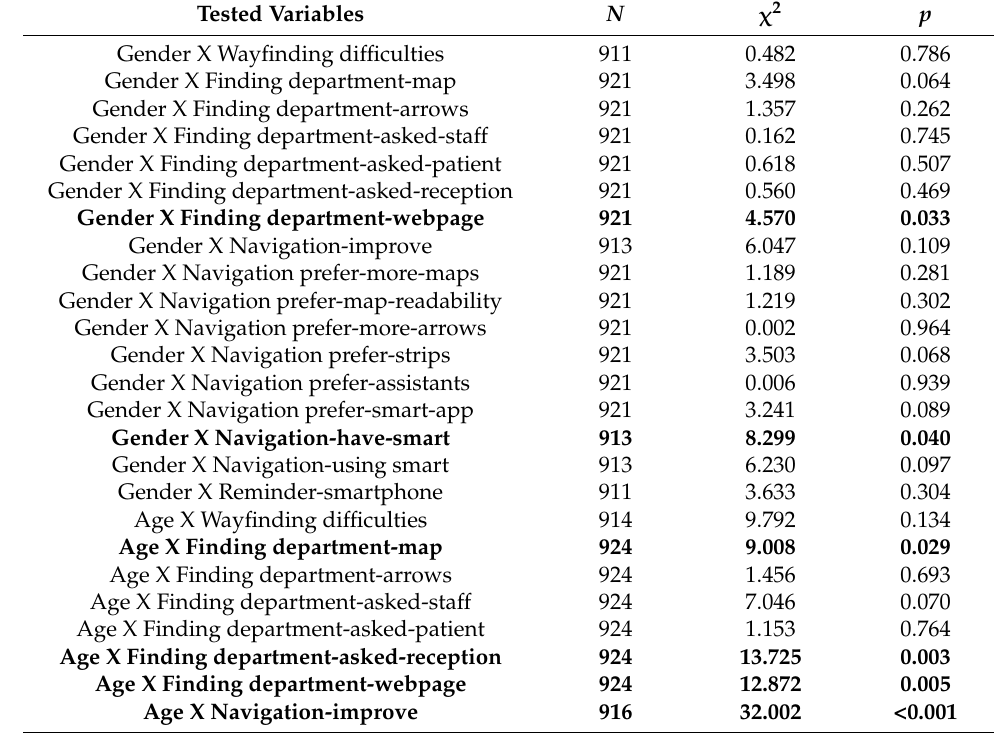
Figure 6. Education and navigational preferences of the respondents: share of positive answers (%). Source: The Authors. Note: variables significantly related to the education are marked: * p < 0.05; ** p < 0.01; *** p < 0.001. Table 3. Effects of the gender, age, and education on wayfinding (selected